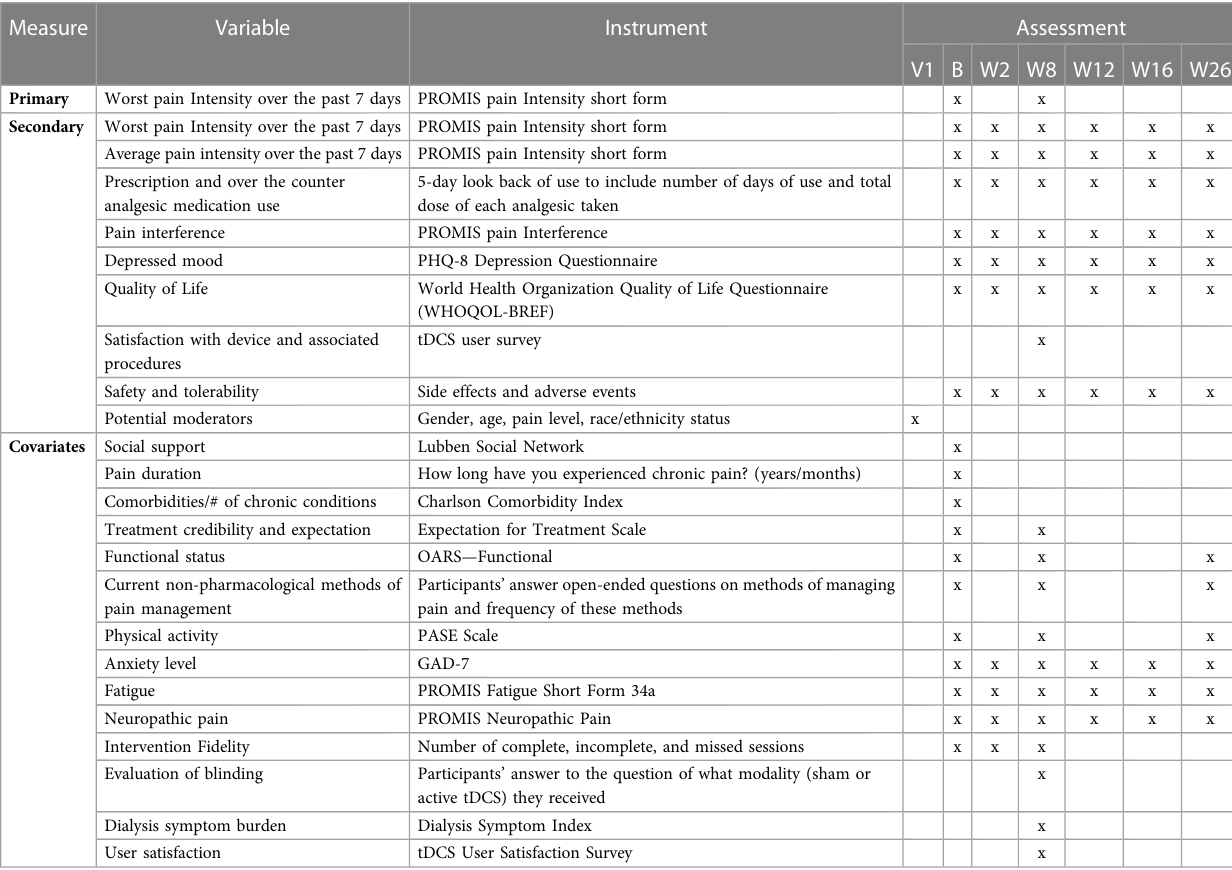
TABLE 2 Study measures.